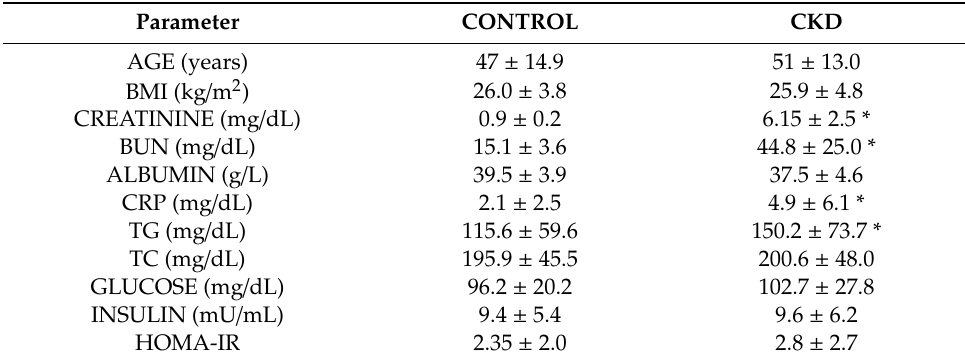
Table 2. Selected biochemical and anthropometric characteristics of the study subjects.